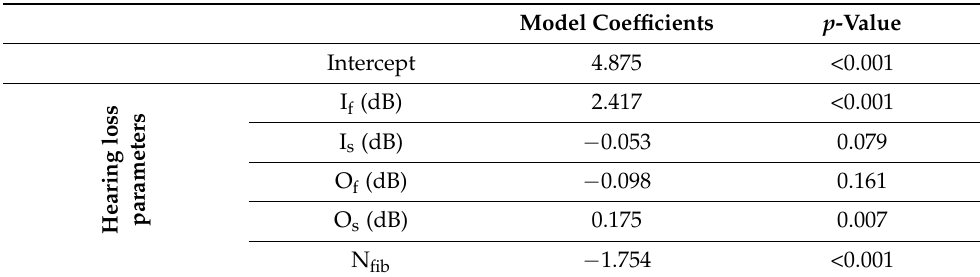
Table 2. Logistic regression coefficients for predicting cochlear implantation recommendation from hearing loss parameters . Ψ